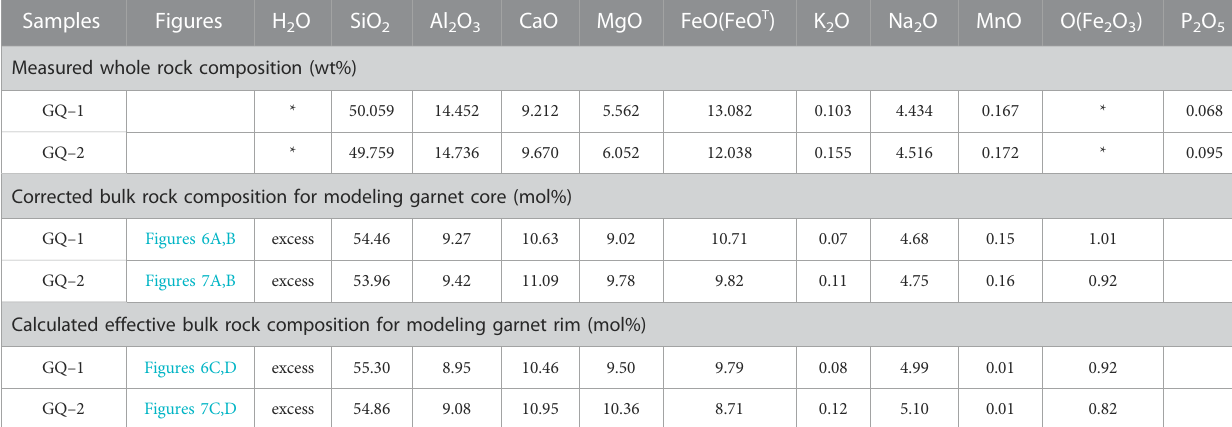
TABLE 3 Whole rock compositions (wt%) together with modi fi ed bulk rock compositions for eclogite at Gaoqiao, western